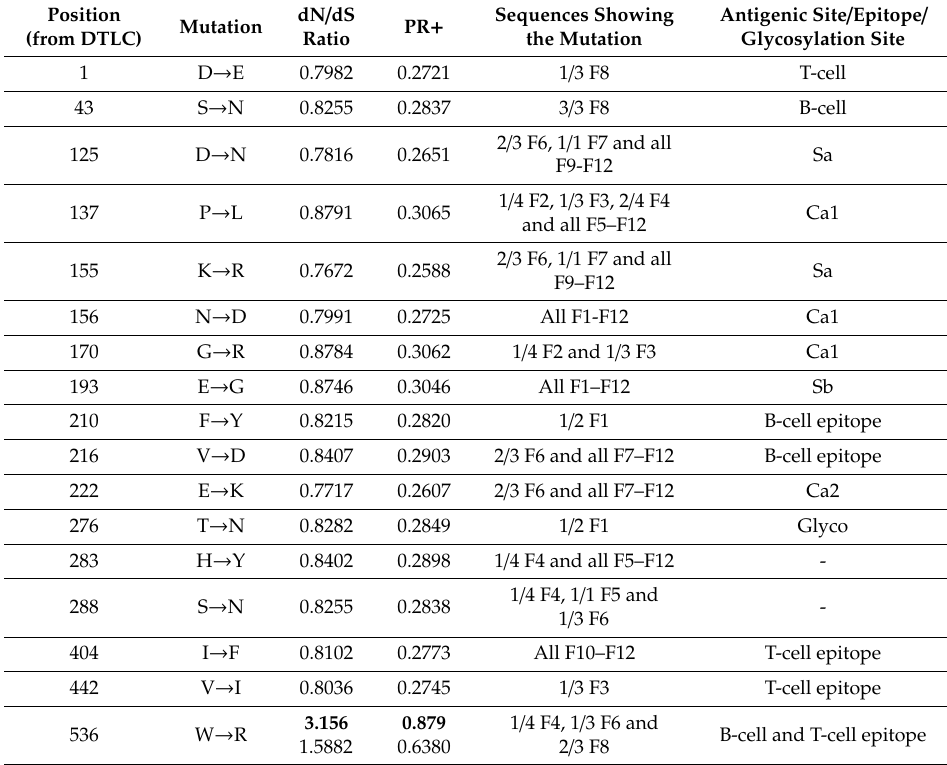
Table 4. Evidence of positive selected amino acid changes and their location in antigenic sites. Position (from DTLC)